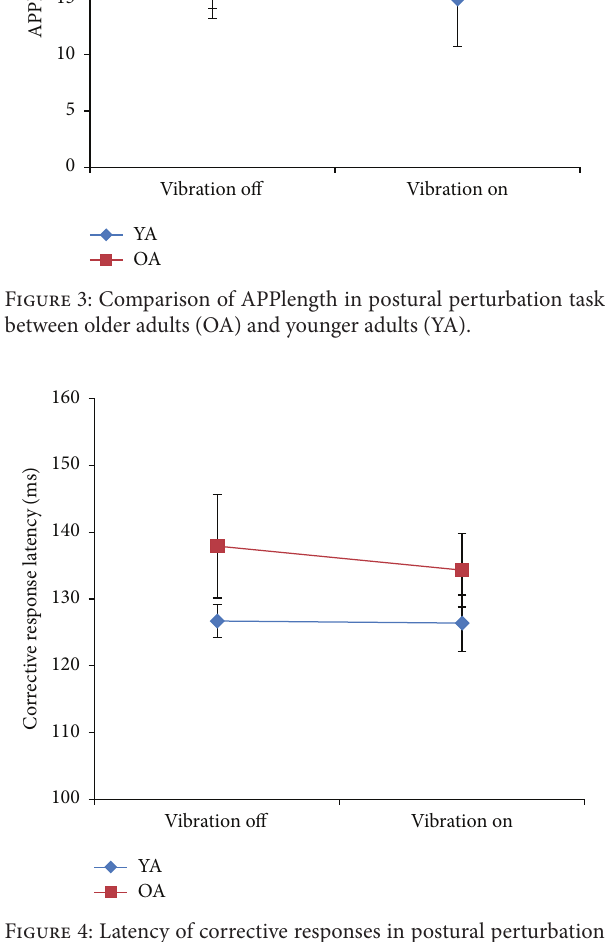
Figure 4: Latency of corrective responses in postural perturbation task between older adults (OA) and younger adults